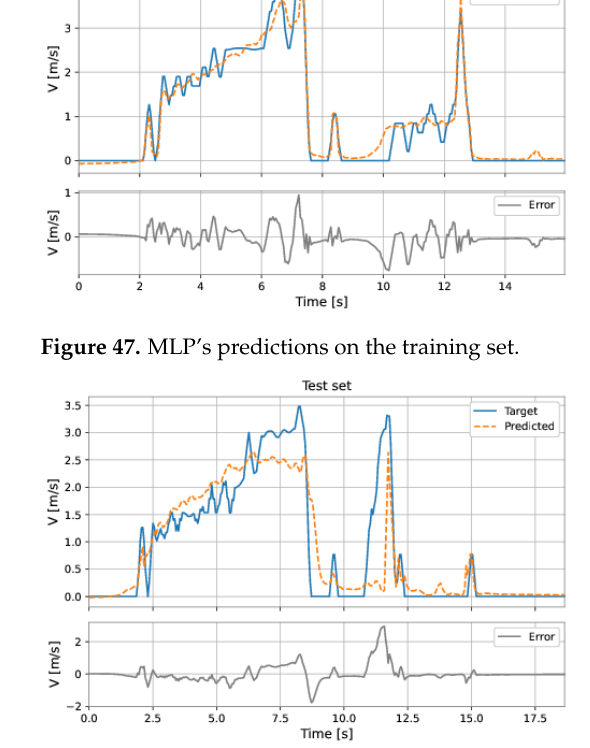
Figure 48. MLP’s predictions on the test